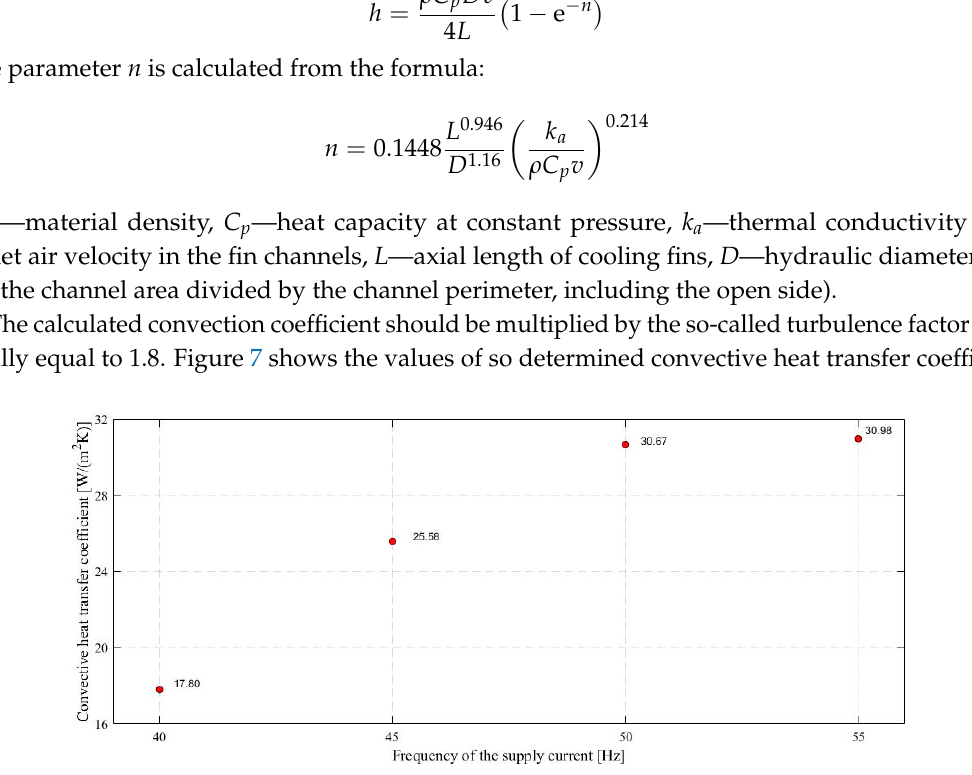
Figure 7. Values of the convective heat transfer coefficients.